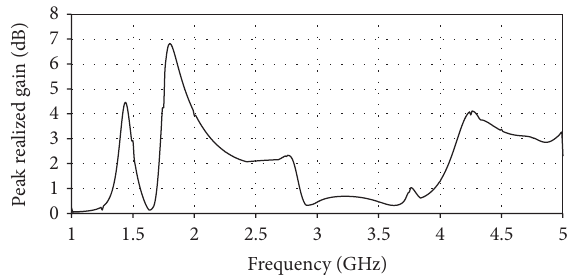
Figure 7: Peak realized gain of the proposed antenna.